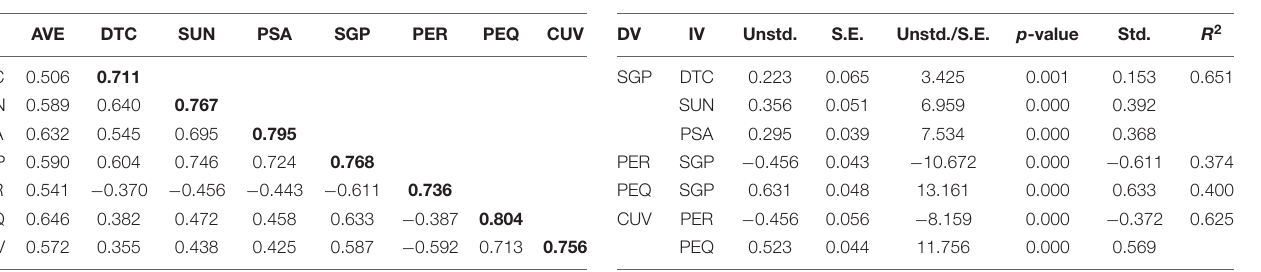
TABLE 4 | Discriminant validity.